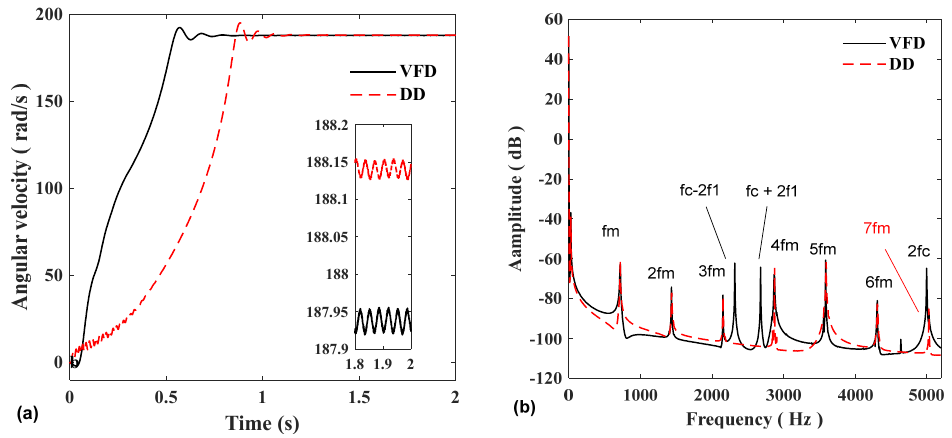
Figure 14. Angular velocity of gear 1: ( a ) time domain; ( b ) frequency domain. The time-domain and frequency-domain diagrams of the meshing force are shown in Figure 15. From the point of view of the time to enter the steady-state, the frequency conversion start time is shorter than the direct start time. From the perspective of force variation, the frequency conversion start amplitude is slightly larger than that of the direct start. The wave composition is roughly the same as the frequency spectrum of the tachogram, which indicates that the difference in amplitude in the time domain is caused by the inverter.